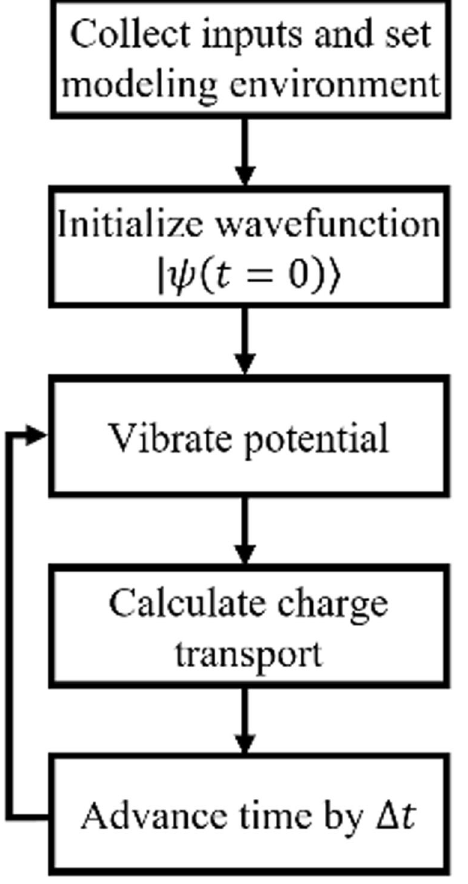
Fig. 5 Schematic representation of the algorithm used for calculating charge transport through a JJ. The algorithm collects inputs about the modeling environment, then it initializes the wavefunction. Following that, a loop will run to calculate the current system state and propagate the system in space and time according to the Hamiltonian